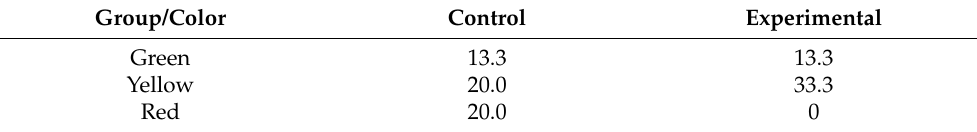
Table 11. Percentage of different alert levels in the experimental and control groups. Group/Color Control Experimental Green